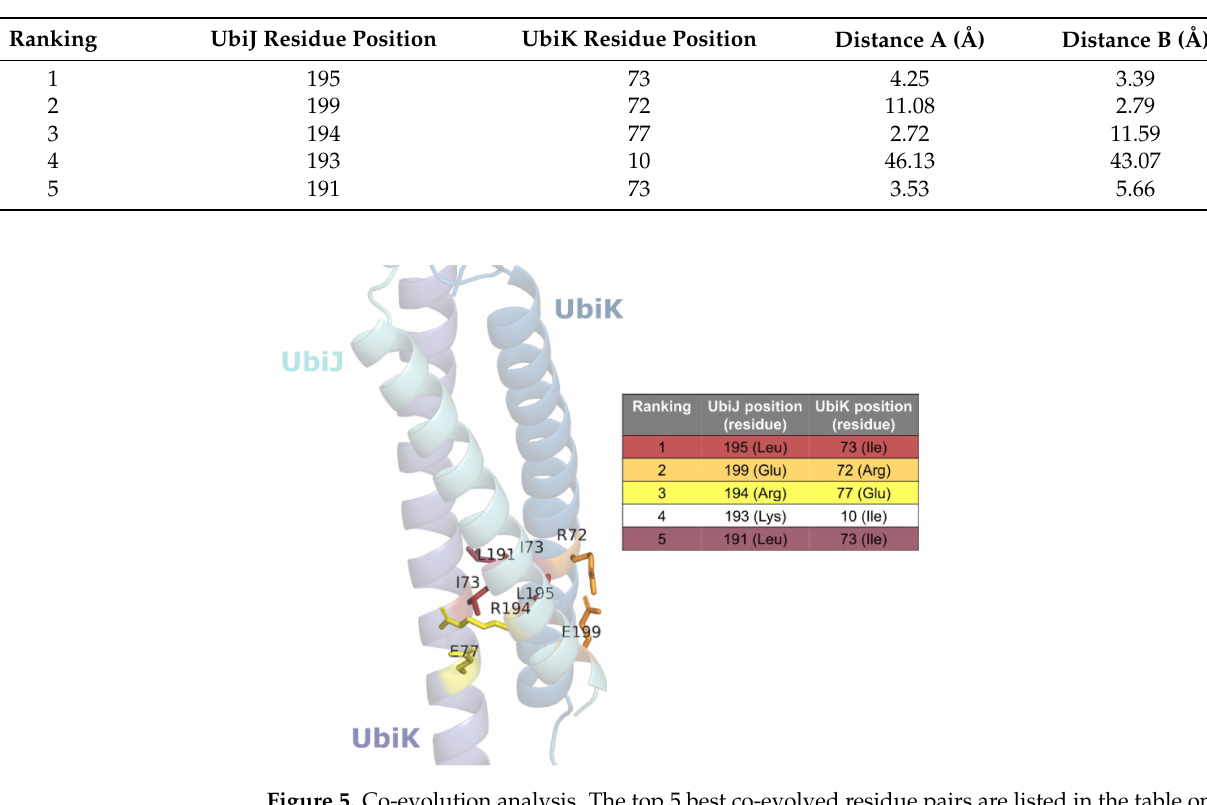
Table 1. Top 5 best co-evolved residue pairs. Distance columns correspond to the minimal distances between heavy atoms of UbiJ and UbiK. A and B indicate the first and the second UbiK chain. All distances are given in Å and residue numbering corresponds to the Uniprot sequence (Uniprot ID: Q46868 for UbiK and P0ADP7 for UbiJ).